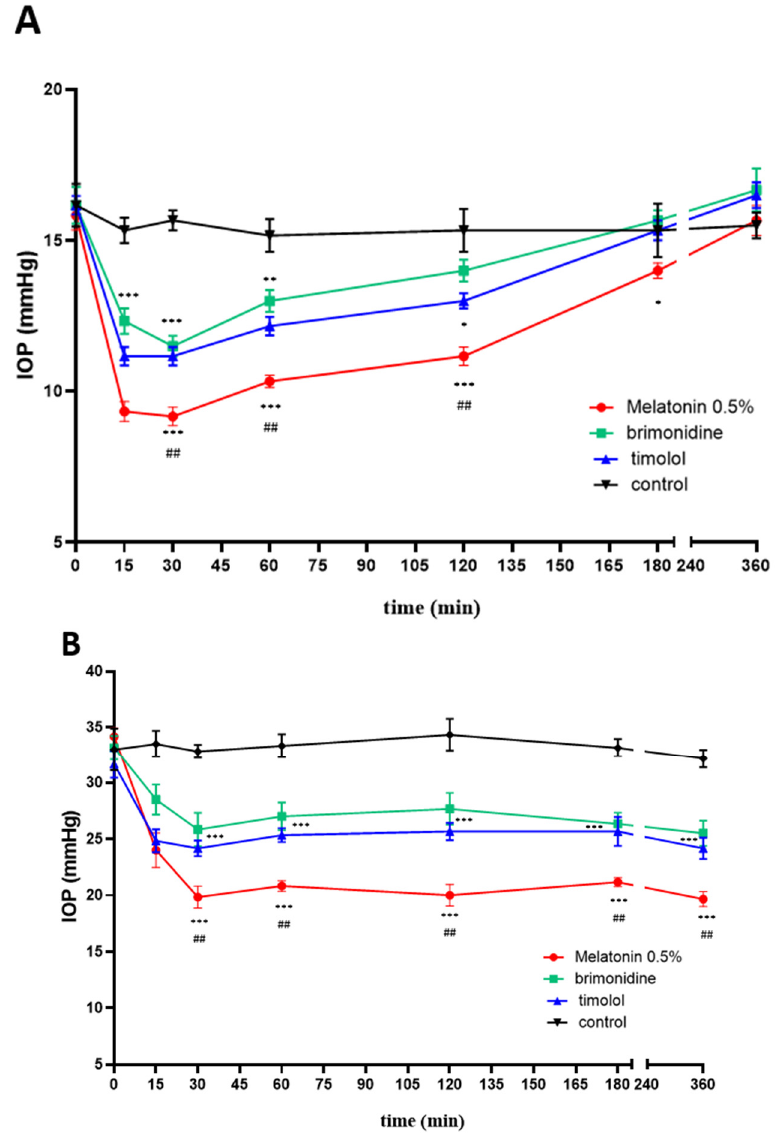
Figure 11. Time-course of the hyponotizing effects of melatonin 0.5%, brimonidine 0.2%, and timolol 0.5% in normotensive ( A ) or hypertensive ( B ) rats. *** p < 0.001, ** p< 0.01, * p < 0.05 vs. control; ## p < 0.01 vs. timolol or brimonidine.